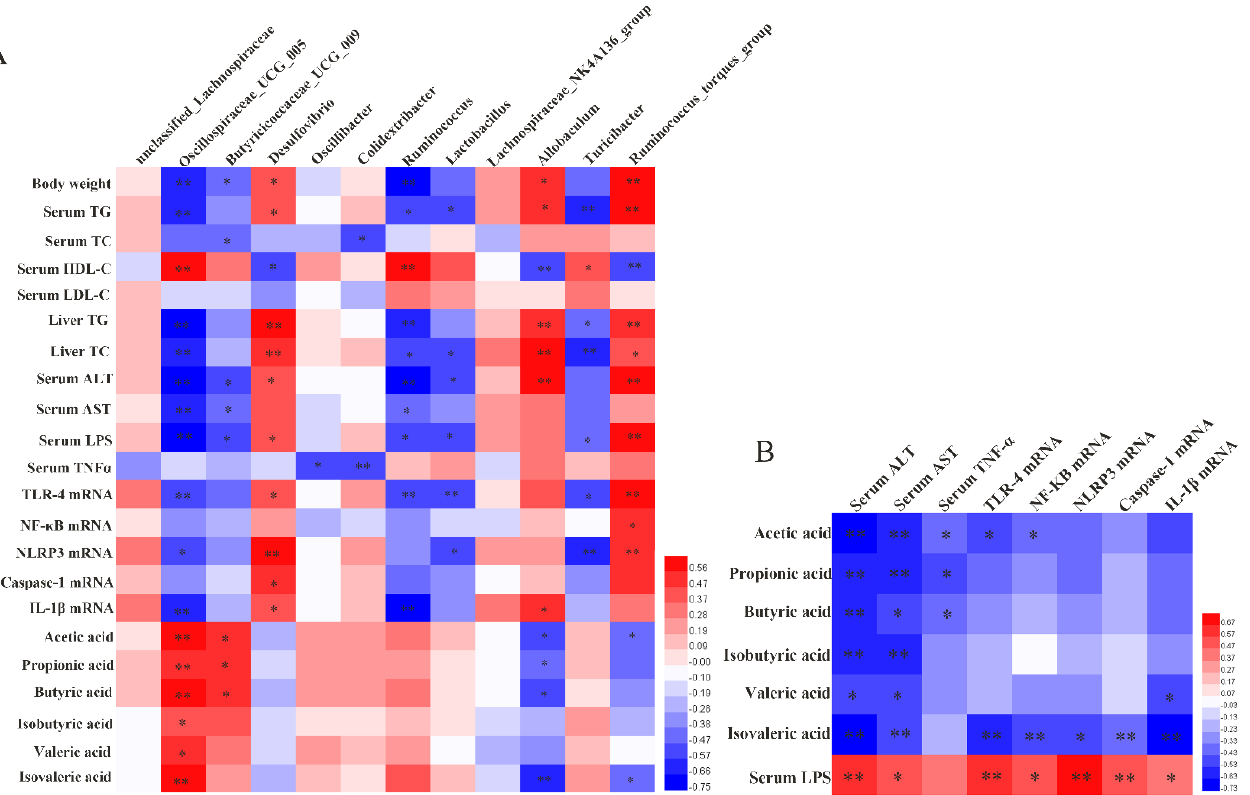
Figure 6. Correlation Analysis. ( A ) The heat map shows the Spearman correlation coefficient among the intestinal differential bacteria, lipid metabolism index, LPS, SCFAs and inflammation indicators; ( B ) the heat map shows the Spearman correlation coefficient between metabolites of gut microbiota (LPS and SCFAs) and inflammation indicators. * p < 0.05 and ** p < 0.01.